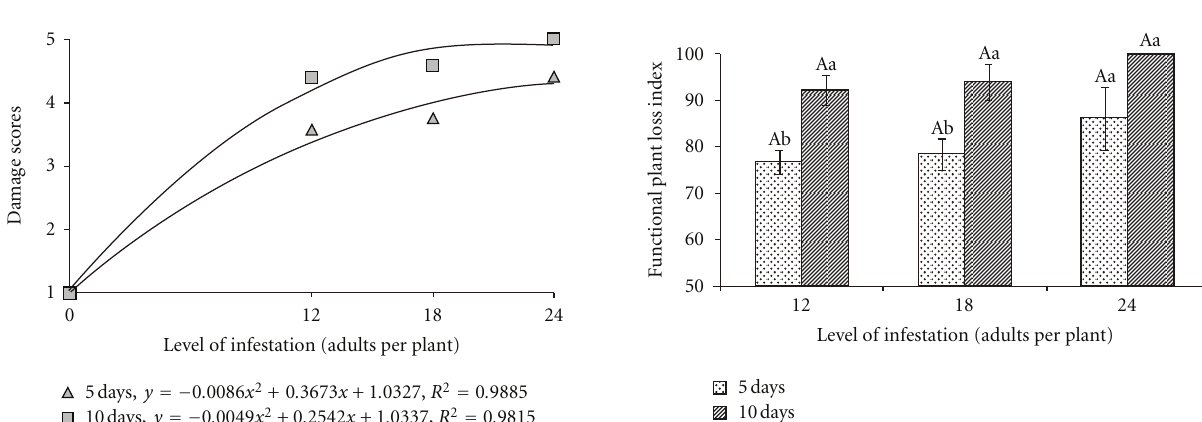
Figure 3: Relationship between infestation levels of M. spectabilis adults and damage scores for B. ruziziensis over 5 or 10 days.